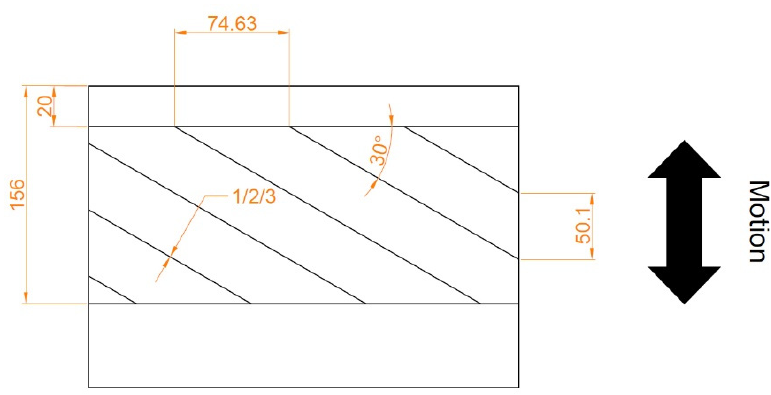
Figure 22. Cylinder liner tested in